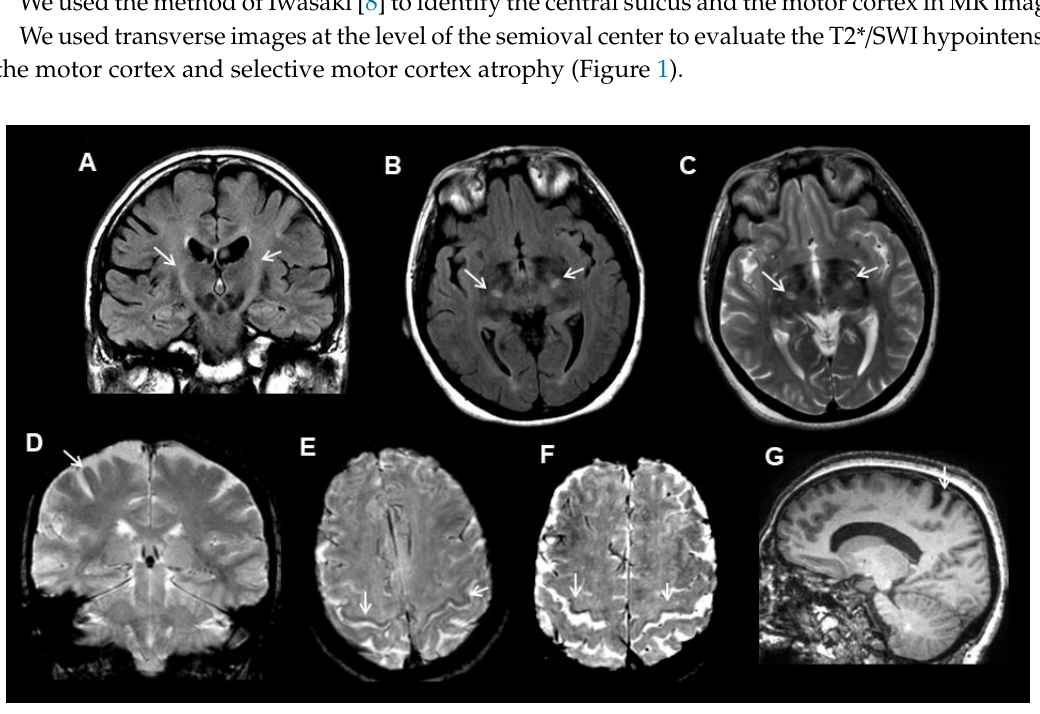
Figure 1. Examples of the MRI (Magnetic Resonance Imaging) features (arrows) in amyotrophic lateral sclerosis (ALS) patients. ( A ) corticospinal tract FLAIR hyperintensity in a coronal image. ( B ) corticospinal tract fluid attenuated inversion recovery (FLAIR) hyperintensity in an axial image. ( C ) corticospinal tract T2 hyperintensity in an axial image. ( D ) motor cortex T2* hypointensity in a coronal image. ( E ) motor cortex SWI hypointensity in an axial image. ( F ) motor cortex SWI hypointensity and widening of the central sulcus in an axial image. ( G ) selective motor cortex atrophy in a sagittal-T1 image.